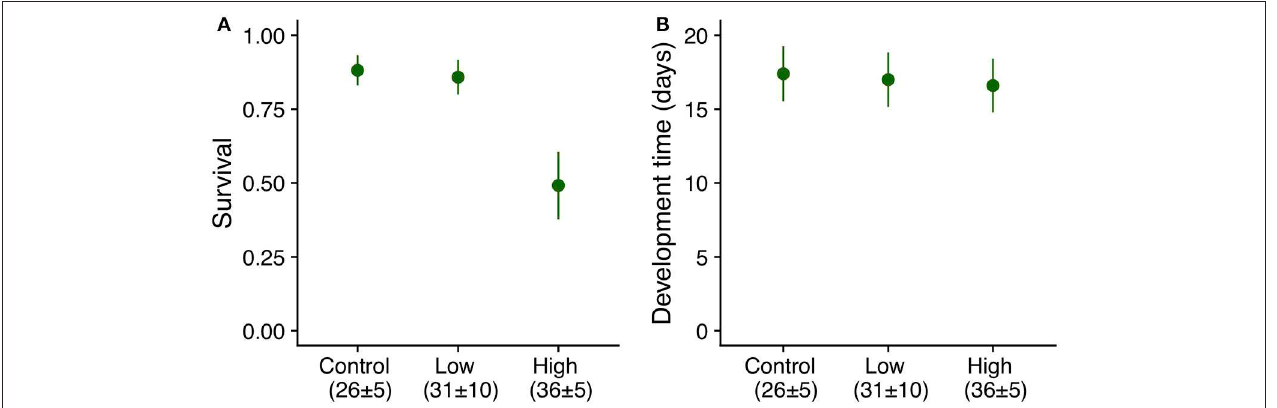
Frontiers in Ecology and Evolution |